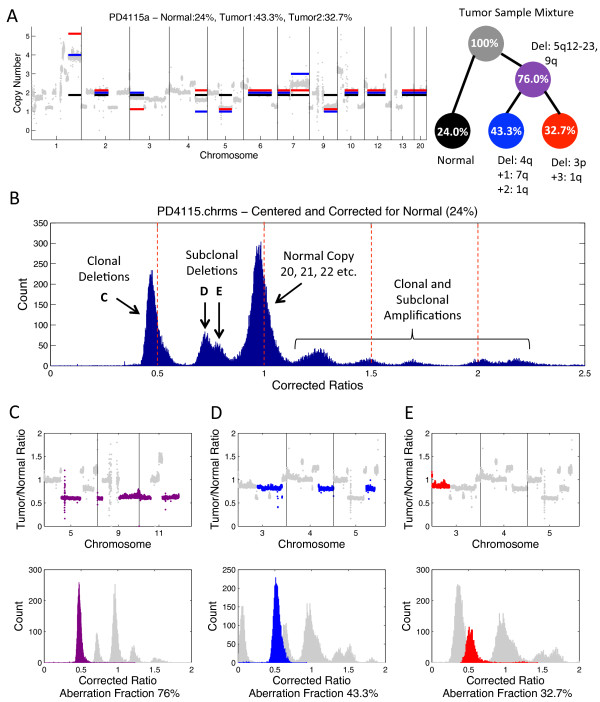
Analysis of the 40× coverage breast tumor PD4115a. (A) (Left) Read depth ratios (gray) and the inferred copy number aberrations calculated by our algorithm when n = 3 including the normal population (black), dominant (clonal) tumor population (blue) and subclonal tumor population (red). (Right) A reconstruction of the tumor mixture with the inferred aberrations and estimated fraction of cells in each subpopulation. (B) Distribution of read depth ratios over 50 kb intervals after centering and correction for 24% normal admixture using a simple linear scaling. Several peaks fall near to expected corrected ratios (0.5, 1, 1.5, 2). Two overlapping but distinct peaks can be seen indicating multiple subclonal deletions in similar proportions (labeled D and E). (C) (Top) Read depth ratios in 50 kb bins for chromosomes 5, 9 and 11, each of which has a clonal deletion (purple). (Bottom) Distribution of read depth ratios after correction for the aberration fraction of 76% of the sample. (D) (Top) Read depth ratios in 50 kb bins for chromosomes 3, 4 and 5, each of which has a subclonal deletion (blue). (Bottom) Distribution of read depth ratios after correction for the aberration fraction of 43.3% of the sample. (E) (Top) Read depth ratios as in (D), but a different subclonal deletion is highlighted (red). (Bottom) Distribution of read depth ratios after correction for the aberration fraction of 32.7% of the sample.